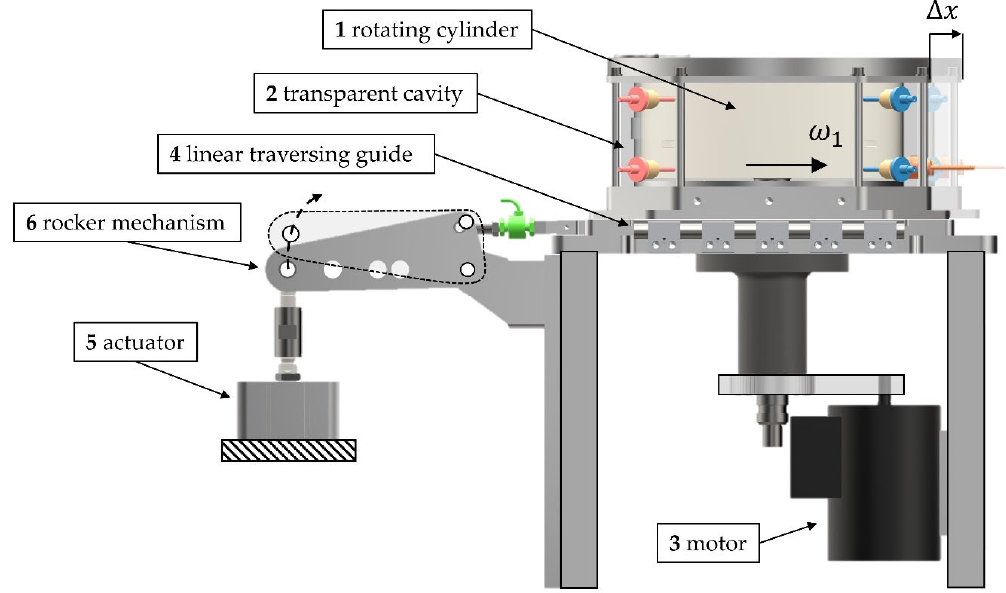
Figure 1. Experiment: Couette apparatus consisting of cylinder 1 rotating inside the transparent cavity 2 , motor 3 , linear traversing guide 4 , rocker mechanism 5 and actuator 6 for radial displacement.